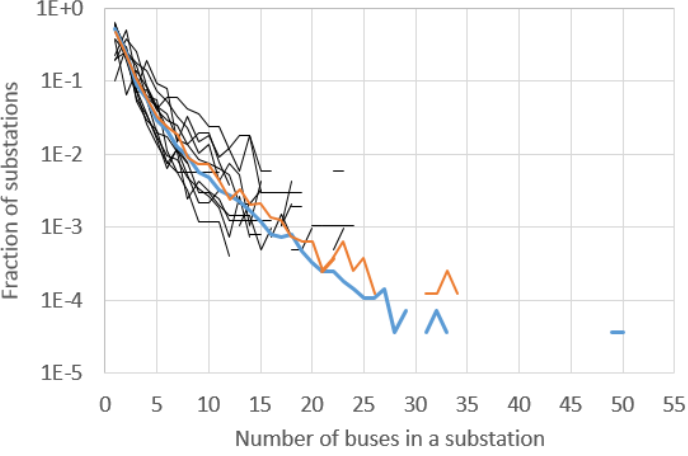
Figure 1. Probability mass function of substations in a case which have a certain number of buses, for eastern interconnect (EI) (blue), western interconnect cases (WECC) (orange), and 12 subset cases (black).